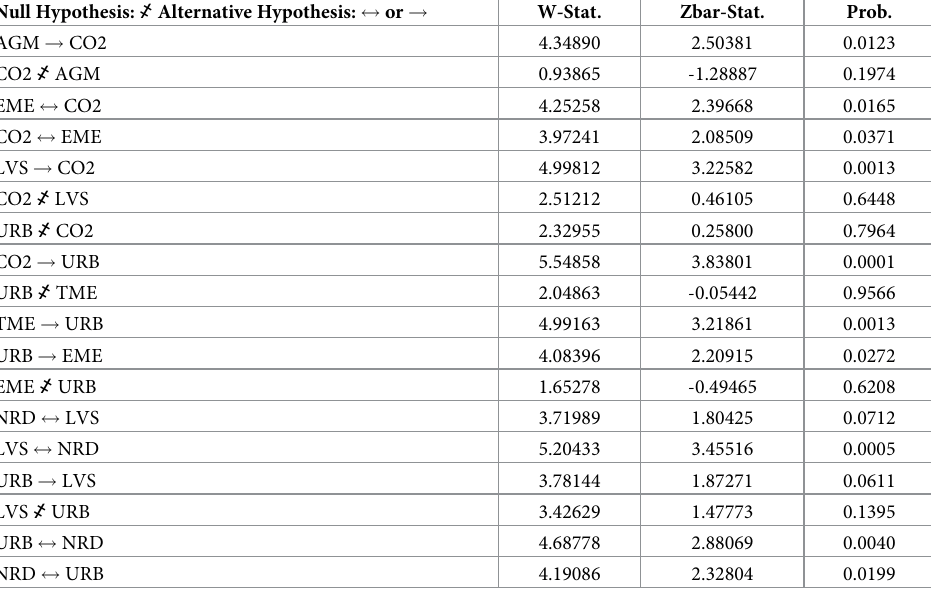
Table 11. Dumitrescu Hurlin panel causality test estimates.